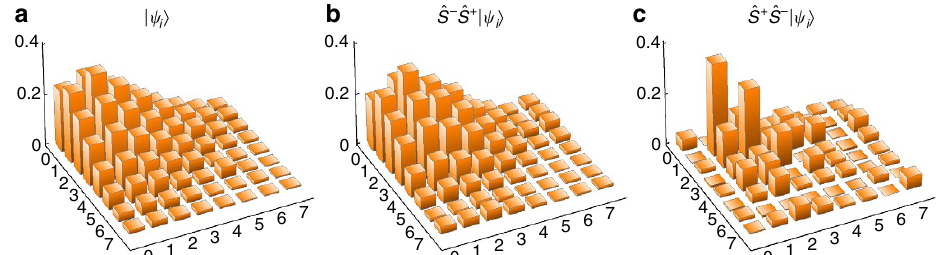
Figure 4 | Experimental results after addition-then-subtraction and subtraction-then-addition. Only the real part of experimentally measured density matrices is shown ( a ) for an initial coherent state c i j i¼ a ¼ 1 : 2